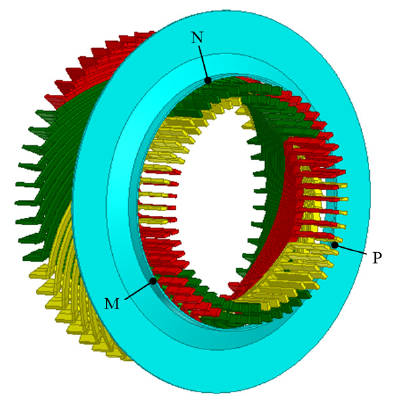
Figure 10. Locations of test sensors.